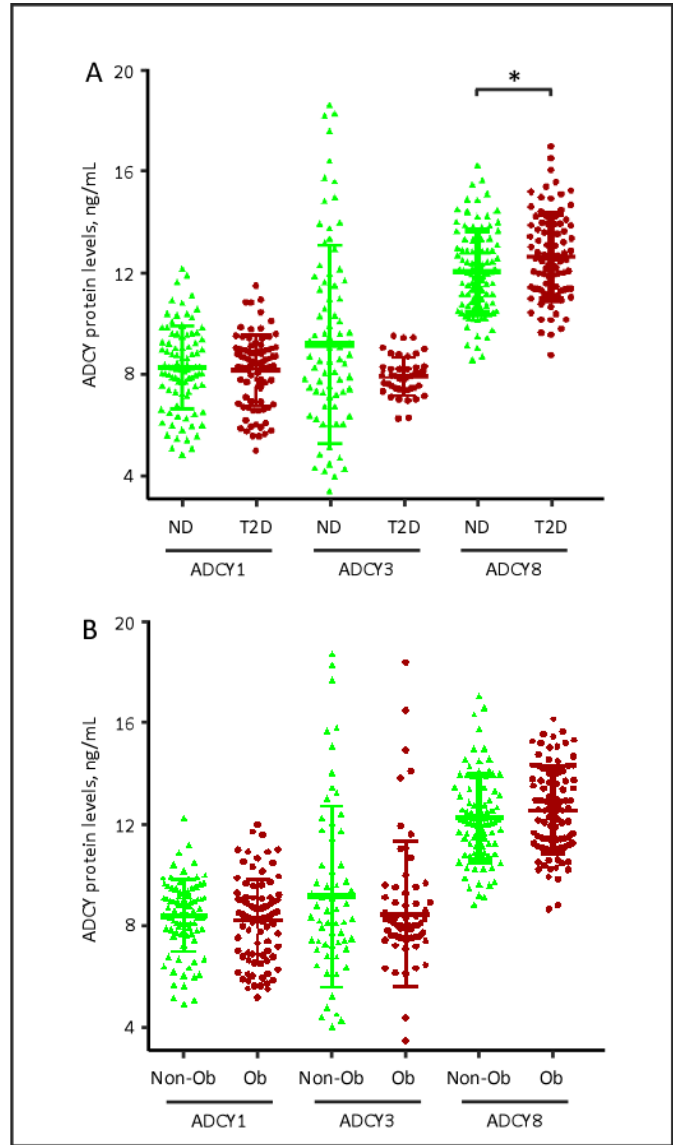
Figure 1. Quantitative analysis of plasma ADCY1, ADCY3 and ADCY8 in ( A ) subjects with and without T2D and in ( B ) subjects with and without obesity. Data are presented as mean ± SD. ADCY, adenylate cyclase; ND, non-diabetic; T2D, type 2 diabetes; Non-Ob, non-obese; Ob, Obese. * p = 0.017). p -Value was calculated using unequal variance t-test.